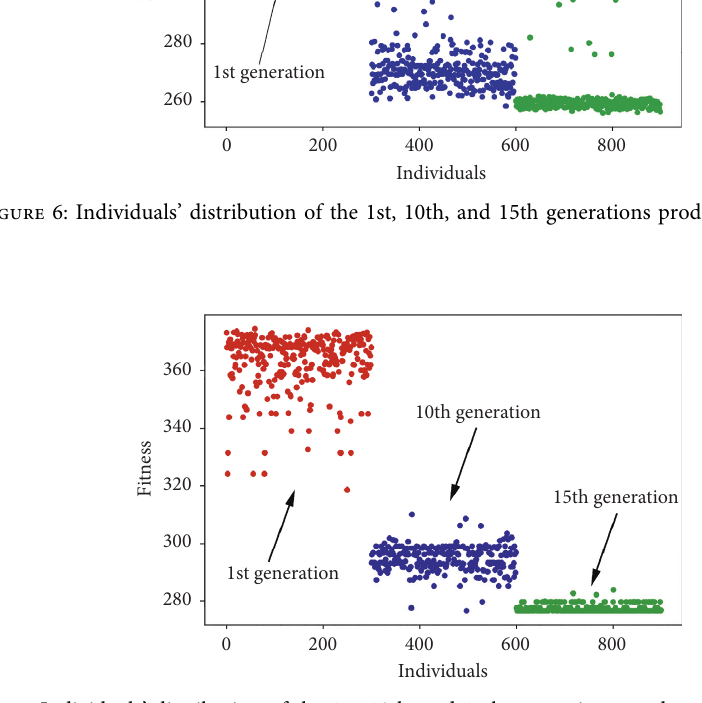
Figure 7: Individuals’ distribution of the 1st, 10th, and 15th generations produced by a general